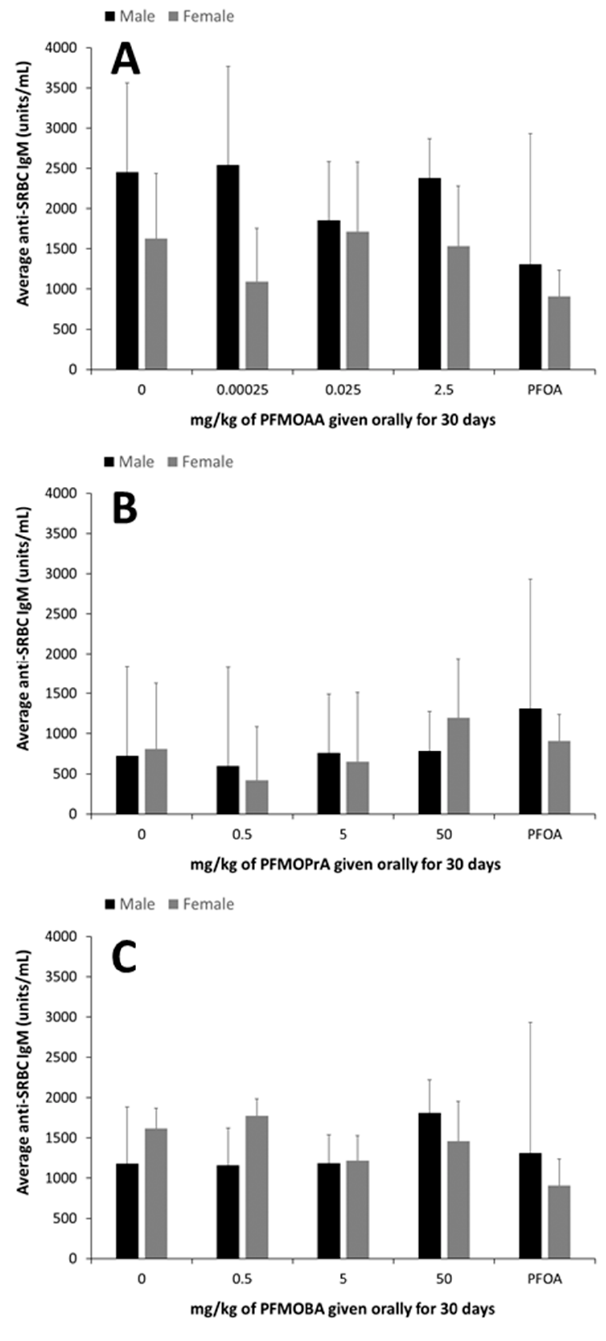
Figure 3. Mean anti-SRBC IgM (units/mL) ( ± standard deviation) in male and female C57BL/6 mice orally exposed to ( A ): PFMOAA, ( B ): PFMOPrA, or ( C ): PFMOBA for 30 days. Serum was analyzed one day after dosing ended and five days after immunizations. No statistical differences in the TDAR were detected in male or female animals given PFMOAA, PFMOPrA, or PFMOBA (Figure 3). n = 4–6/dose for PFMOAA, PFMOPrA, PFMOBA, and 2–3/dose for PFOA-positive control (note that the PFOA-positive control was included from animals evaluated in a separate PFAS study). Abbreviations: sheep red blood cell (SRBC); T cell-dependent antibody response (TDAR);